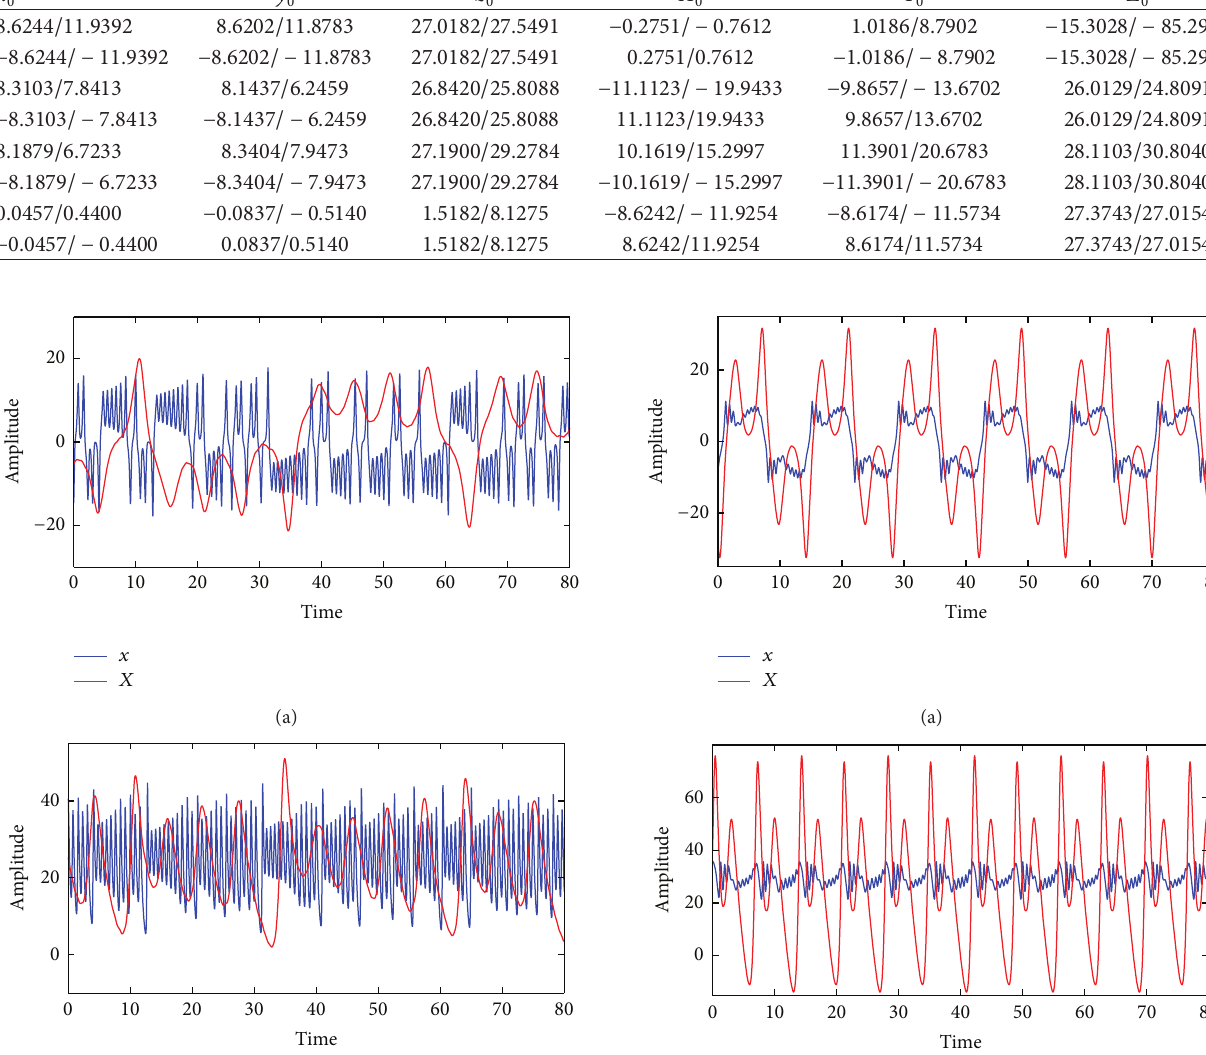
Table 2: Nontrivial equilibrium points of the coupled system for 𝑐 = 0.15 (numerator) and 𝑐 = 0.8 (denominator). 𝑥 0